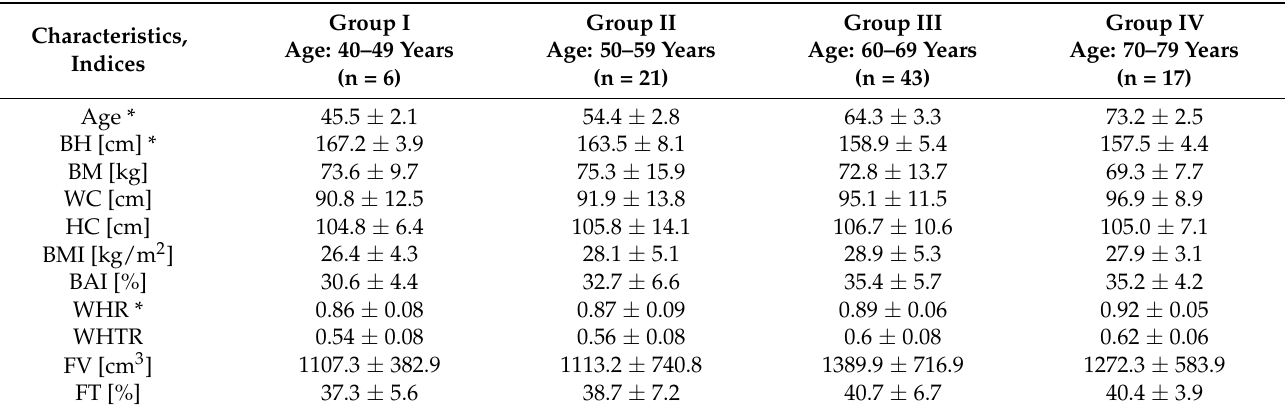
Table 1. Anthropometric characteristics and indices.